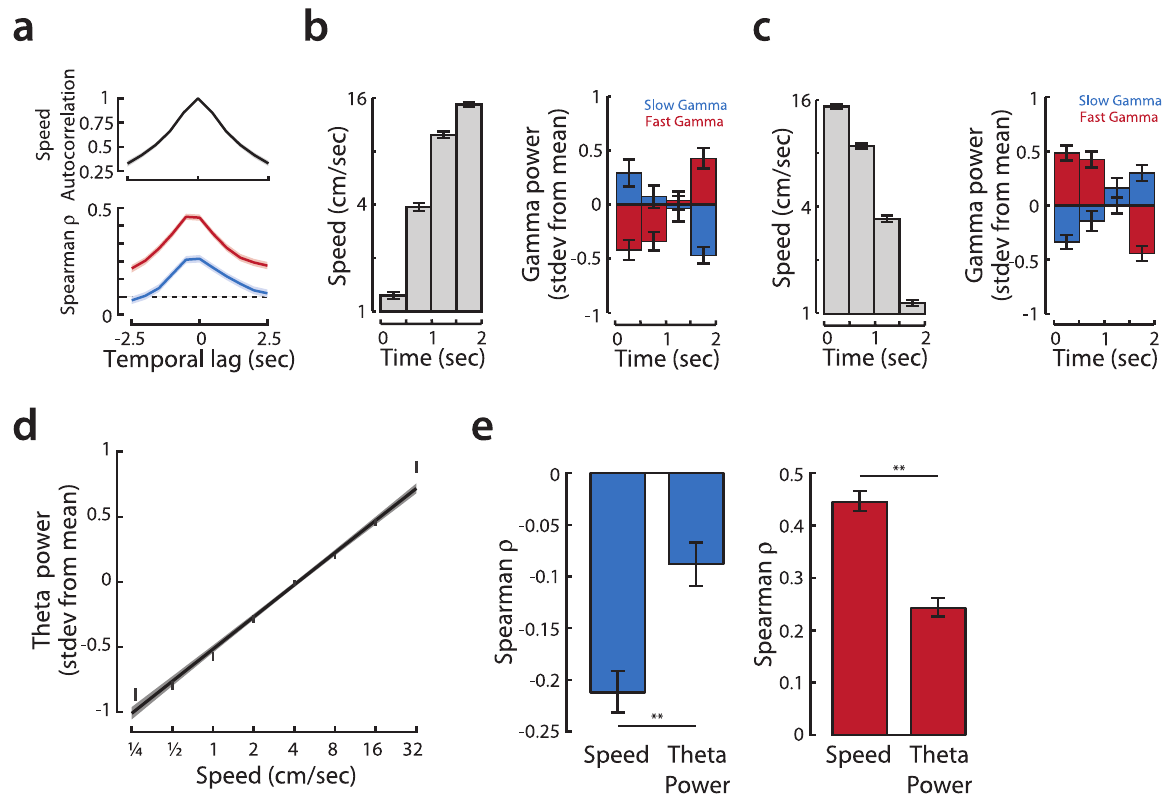
Figure 4. Modulation of gamma oscillations by speed in CA1 is rapid. a, (top) The autocorrelation of speed (shown with bootstrap 95% confidence interval) during the first exposure shows a rapid fall-off of on the timescale of , 1 second. (bottom) Both fast and slow gamma power is most modulated by the animal’s speed measured within a second of the gamma power estimate, implying a rapid timescale of modulation. Shown are the Spearman correlation and bootstrap 95% confidence interval of fast (red) and slow (blue) gamma power with log(speed) for offsets in speed measurement ranging from 2 2.5 to 2.5 s relative to the 0.5 s window used to estimate gamma power. b, Rapid and opposing changes in the power of slow and fast gamma are apparent in 2 second windows over which rats’ speed increase from less than 2 cm/s to more than 10 cm/s. (left) Increasing mean speed (with standard errors) in 0.5 s windows corresponding to the isolated increasing speed incidents. (right) Mean slow gamma power (blue bars with standard errors) decreases significantly, while fast gamma simultaneously increases significantly (red bars) over the course of the two-second increasing speed events. c, Same analysis as ( b ) but for 2 s windows when speed decreased from more than 10 cm/s to less than 2 cm/s. Periods of decreasing speed are marked by an increase in slow gamma power (blue bars) and a concomitant decrease in fast gamma power (red bars). d, Correlation between theta power and log(speed). The graph shows population data of normalized power of theta oscillation (7–9 Hz) vs. speed, both measured over 0.5 s windows. Points represent binned means with standard error; line shows linear regression of underlying data with 95% confidence intervals. e, Speed is a better predictor of fast and slow gamma power than theta power. Comparison of Spearman correlation log(speed) or theta power with fast gamma power (red) and slow gamma power (blue). Depicted are correlations with bootstrap 95% confidence intervals. **p , 0.01.